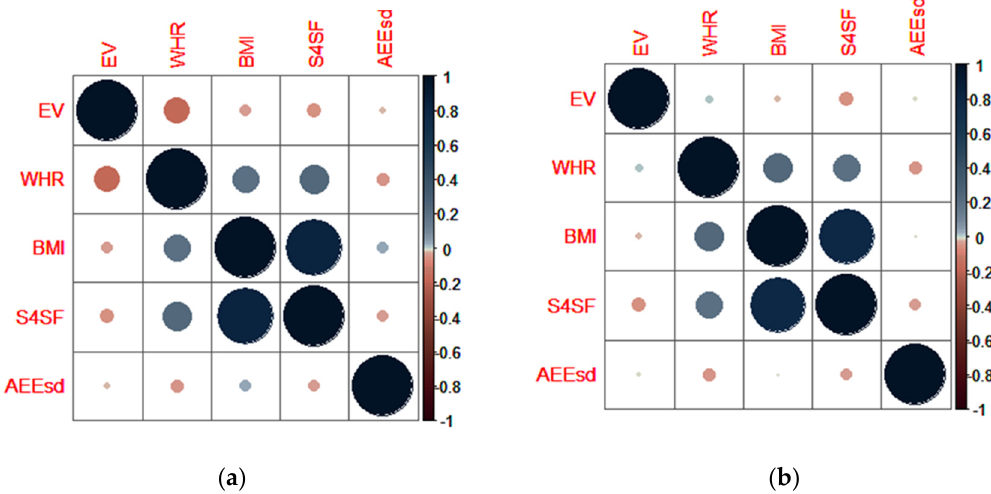
Figure 4. Spearman correlation matrix which shows the interplay between eveningness in energy intake (EV), anthropometric characteristics (WHR, BMI, and S4SF) and active energy expenditure during school days (AEE sd ) for the female population at the age of: ( a ) 15/16; ( b ) 18/19. during school days (AEE sd ) for the female population at the age of: ( a ) 15 / 16; ( b ) 18 / The values of statistical significance of correlation ( p -values) as well as values of Spearmans rank correlation coefficients between variables are available in the Supplementary Data (Tables S1–S8).